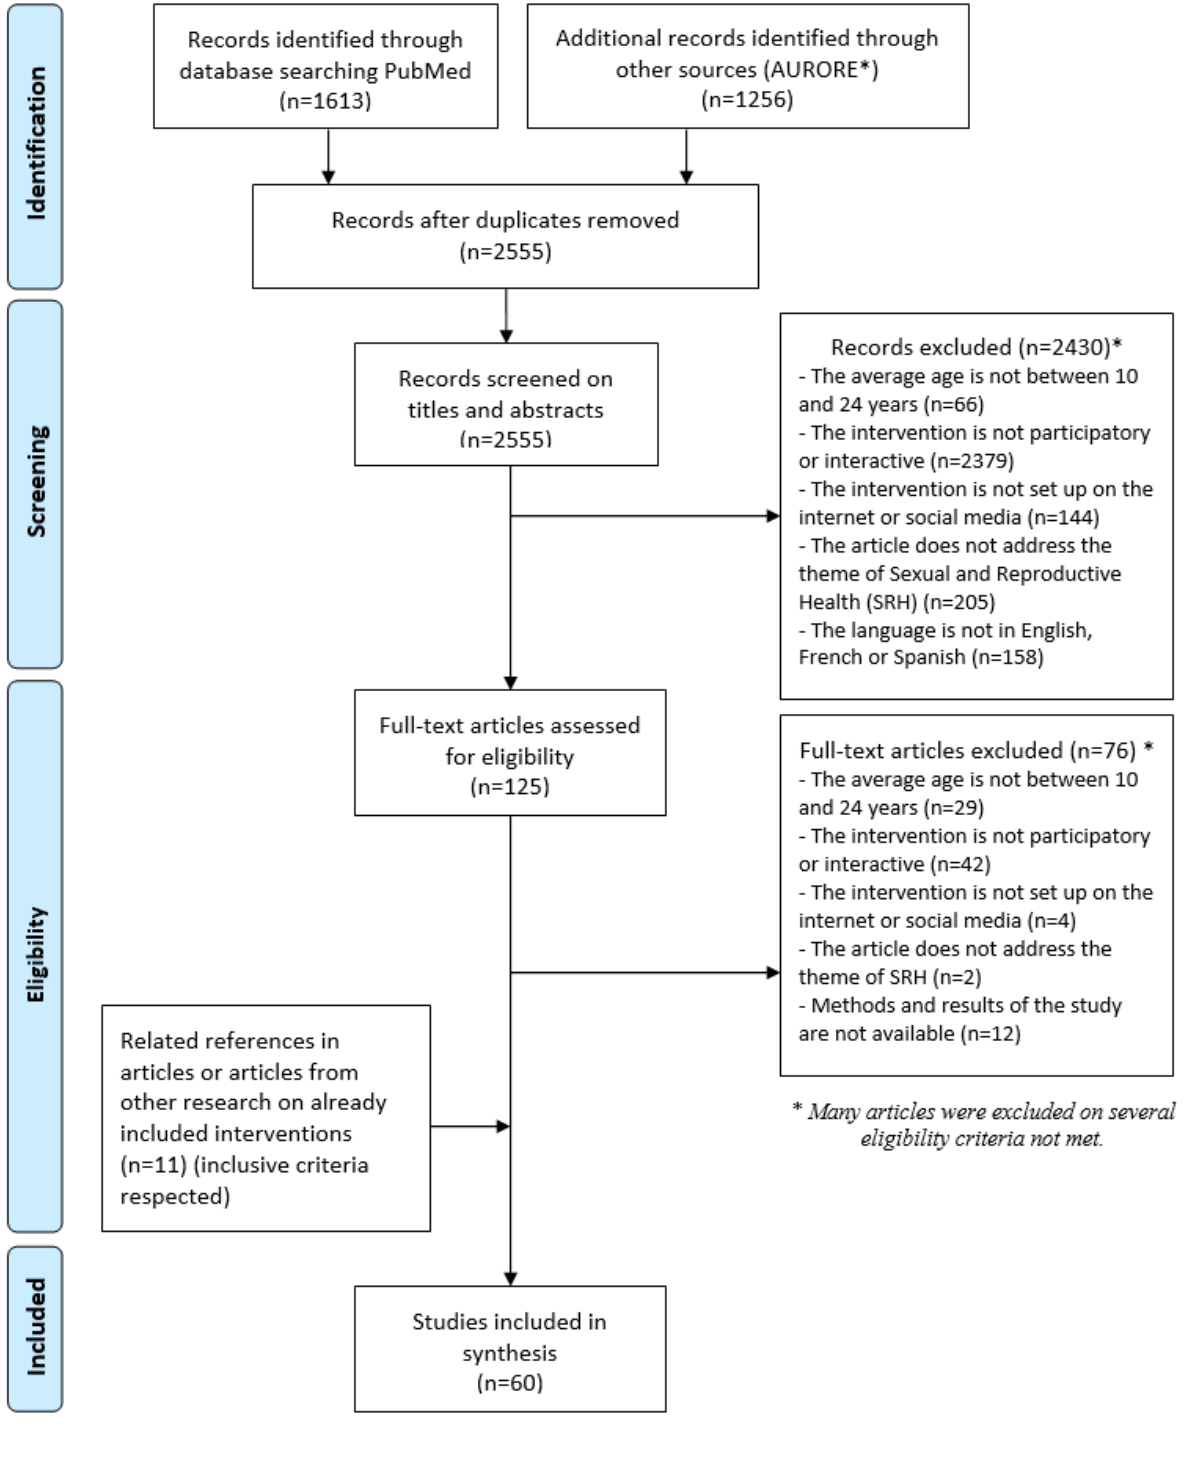
Figure 1. Flow chart of the literature reviewing process. Aurore is a database of Institut National d’Études Démographiques (a French public research institute) that combines scientific databases and grey literature, allowing access to a range of databases and electronic